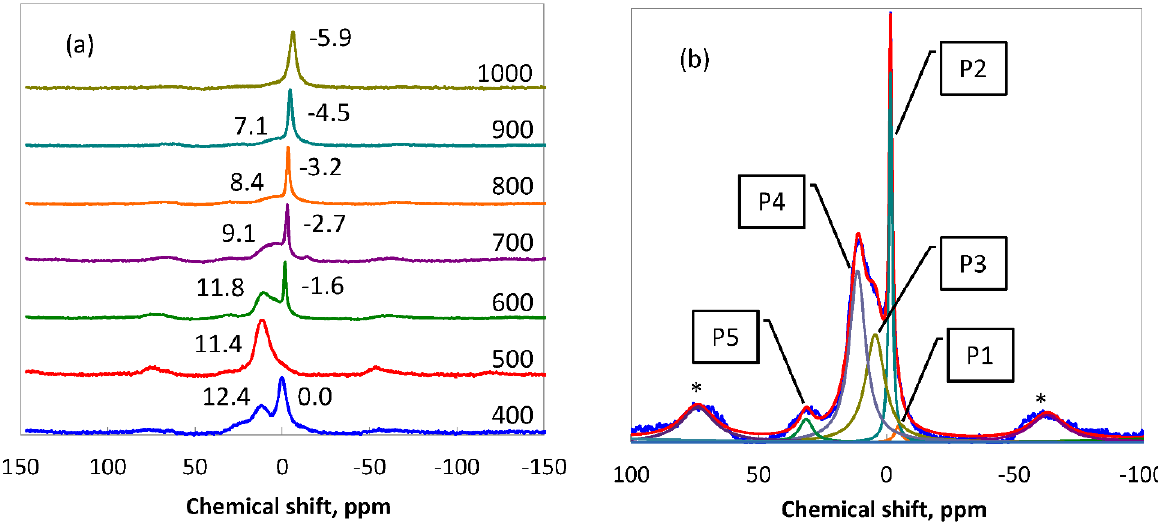
Figure 7. 31 P MAS NMR spectra of polyimide-derived carbons obtained with phosphoric acid (H 3 PO 4 -series) at different temperatures ( a ) and deconvolution of 31 P MAS NMR spectrum of polyimide-derived carbon obtained with phosphoric acid at 600 °C ( b ).